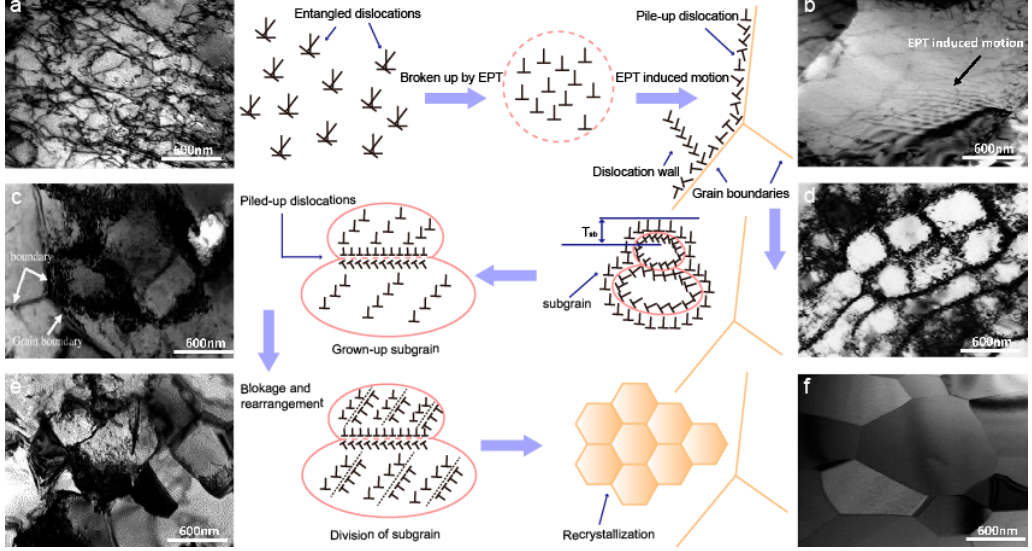
Figure 13. Schematic diagram of dislocation behaviour during recovery and recrystallization and ( a – f ) corresponding TEM images of the Ti-6Al-4V alloy during the process [124].